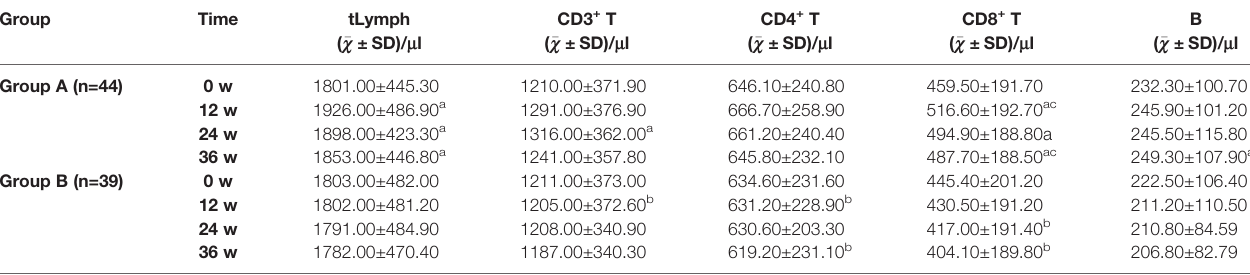
TABLE 5 | Results of peripheral blood immune cell test in OBI